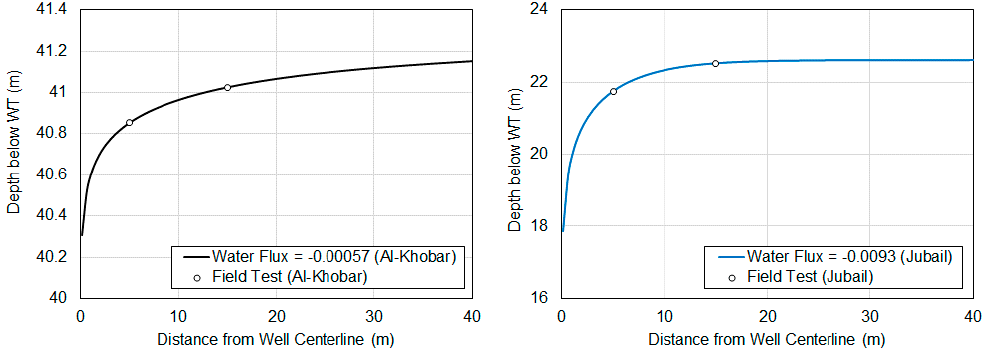
Figure 12. Measured versus computed drawdown curves at the Al-Khobar and Jubail sites.